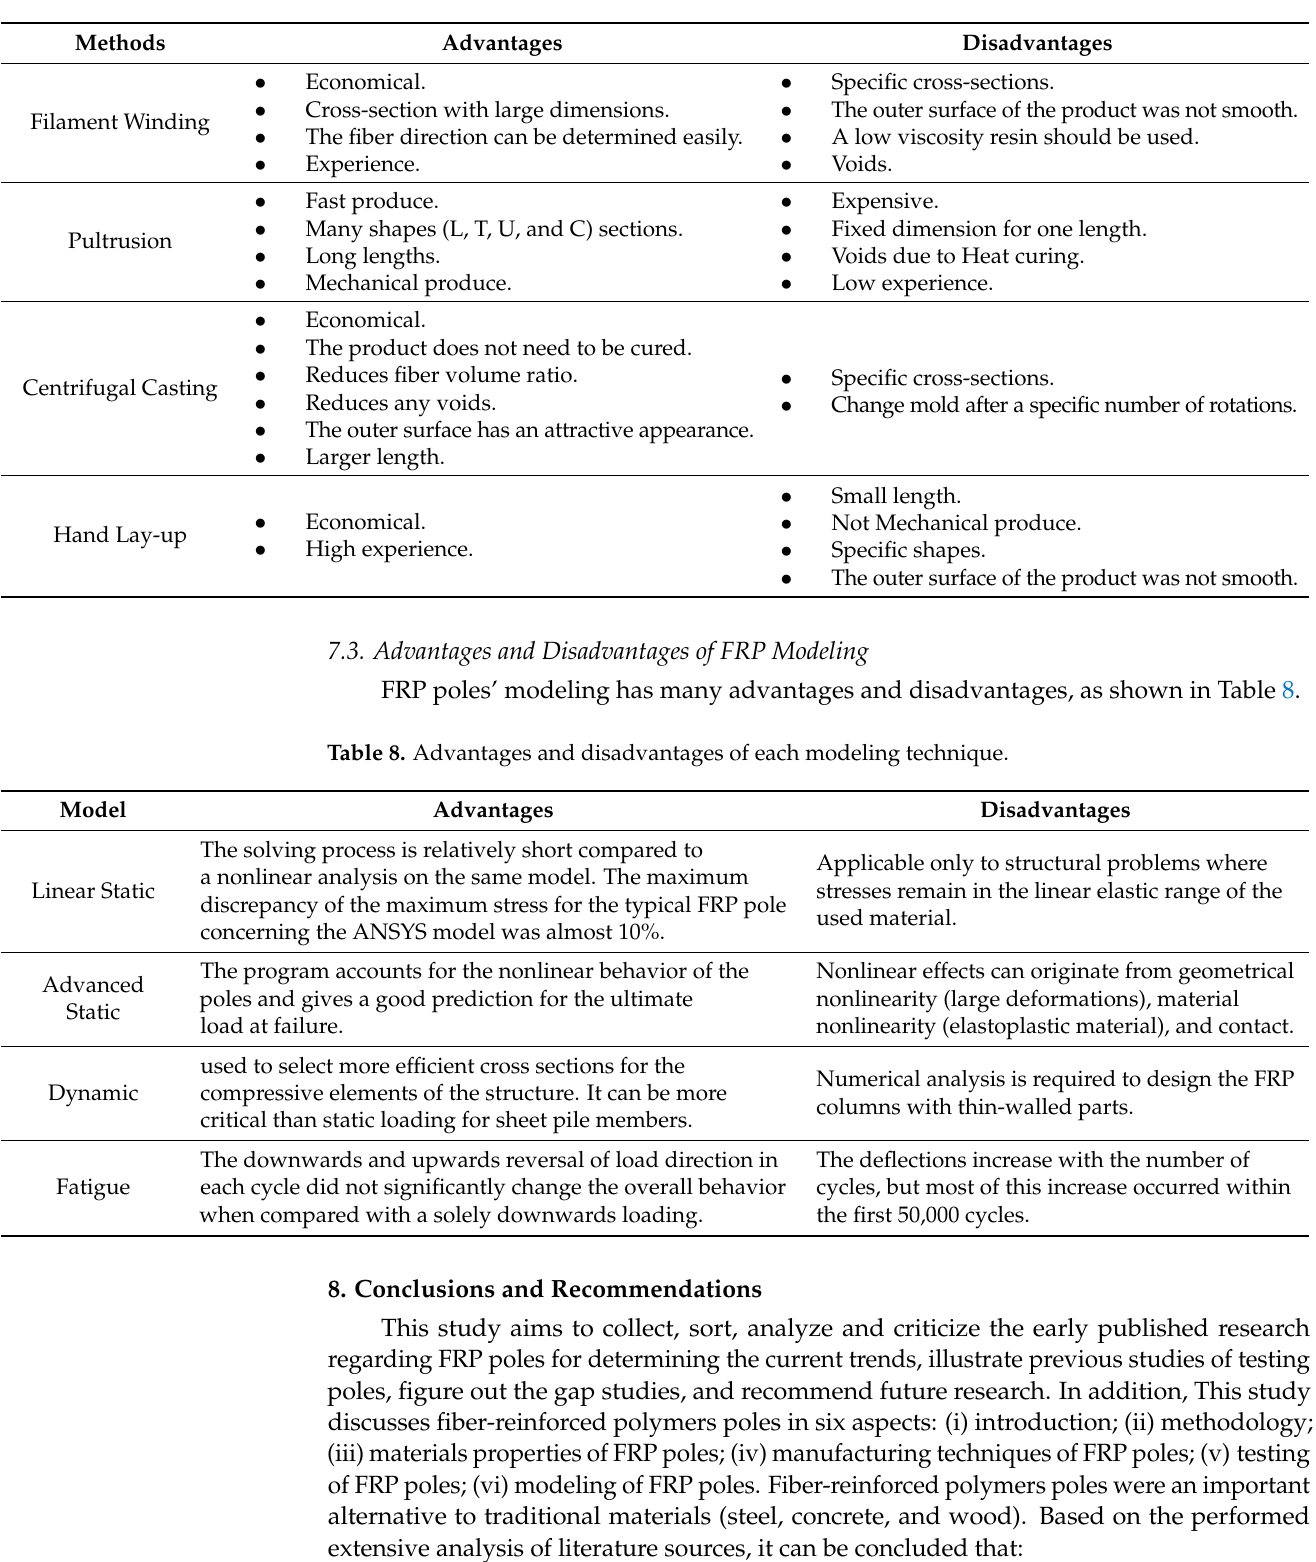
Table 7. Comparison between fiber-reinforced polymer poles manufacture